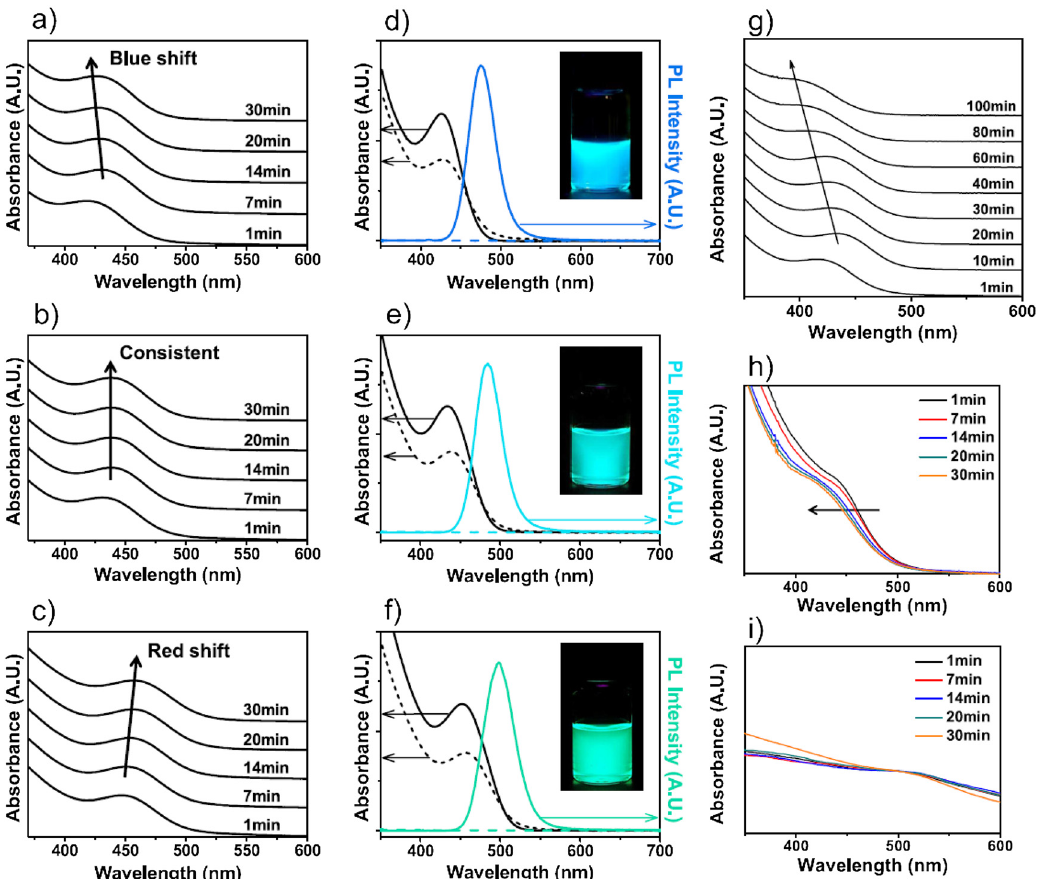
Figure 11: Temporal evolution of the UV – vis absorption spectrum of InP QDs for the initial 30 min at (a) 130 ° C, (b) 150 ° C, and (c) 170 ° C; the absorption and emission spectra of InP and InP/ZnS QDs prepared at (d) 130 ° C, (e) 150 ° C, and (f) 170 ° C; and temporal evolution of the absorption spectrum of InP cores during synthesis at 130 ° C using (g) InAc 3 , (h) InCl 3 with acetic acid, and (i) InCl 3 without acetic acid. The dashedandsolidlinesin(d) – (f)representtheInPcoreandtheInP/ZnScore/shellQDs,respectively.The insetshowsanimageoftheInP/ZnS solution under 365 nm illumination [162].